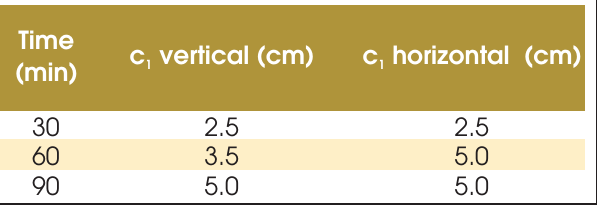
Table 9 – Minimum c for type 12-4 ribbed slab 1